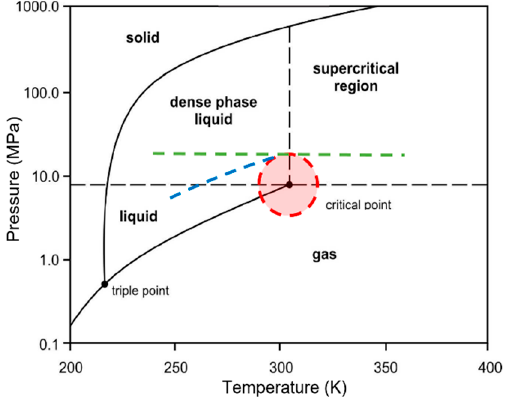
Figure 3. Illustration of Pipeline Operational Limits.